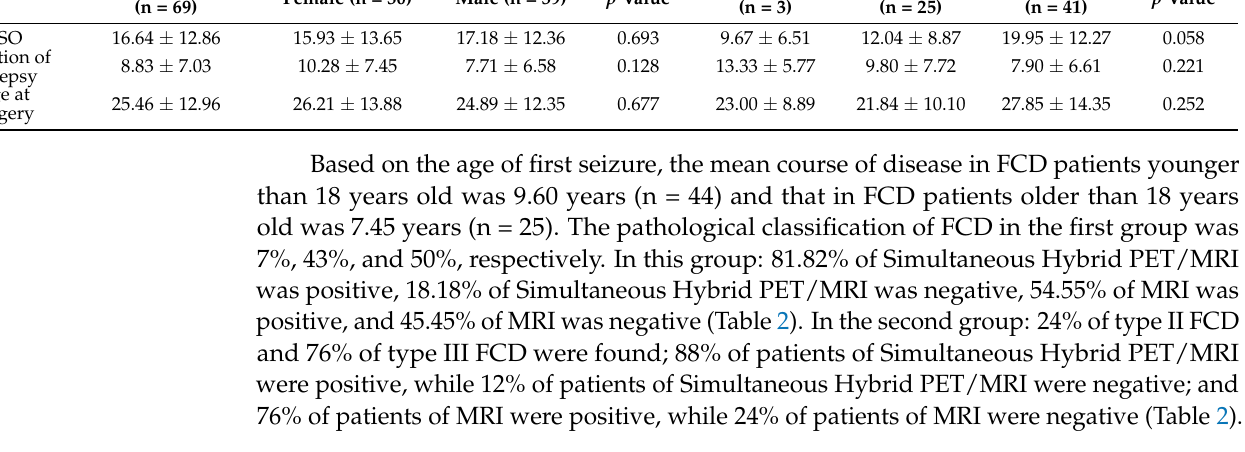
Table 2. Demographic data of patients according to age at surgery and seizure